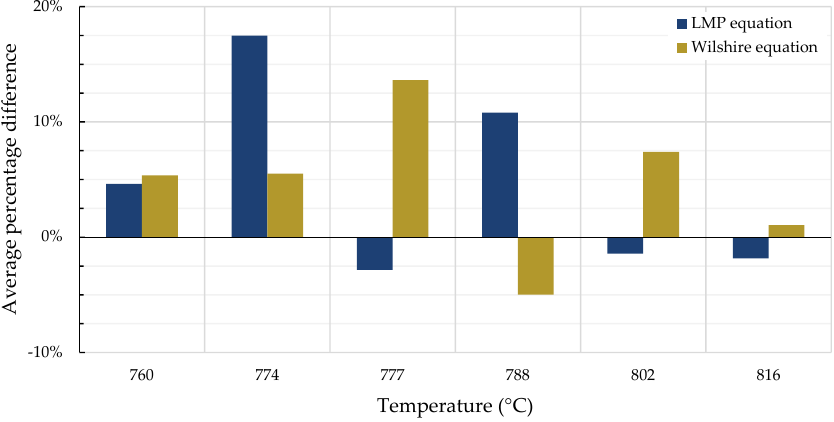
Figure 12. Average percentage difference of calculated and experimental rupture times for Nimonic 105. The percentage differences of the calculated rupture time for the longest test duration of each alloy is defined